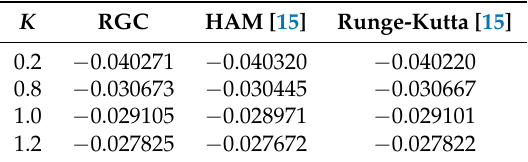
Table 7. Comparison of RGC, HAM and Runge-Kutta solution of C (cid:48) N = 0.8 and Sc = 0.24.